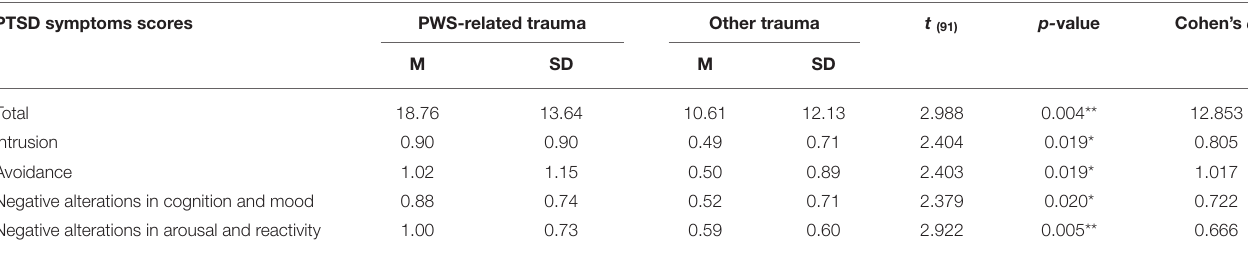
TABLE 3 | T-test of independent variables on PTSD symptoms scores in PWS-related trauma vs. other trauma. PTSD symptoms